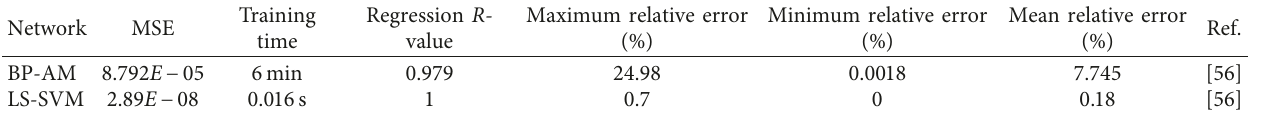
Table 9: A comparison of two training